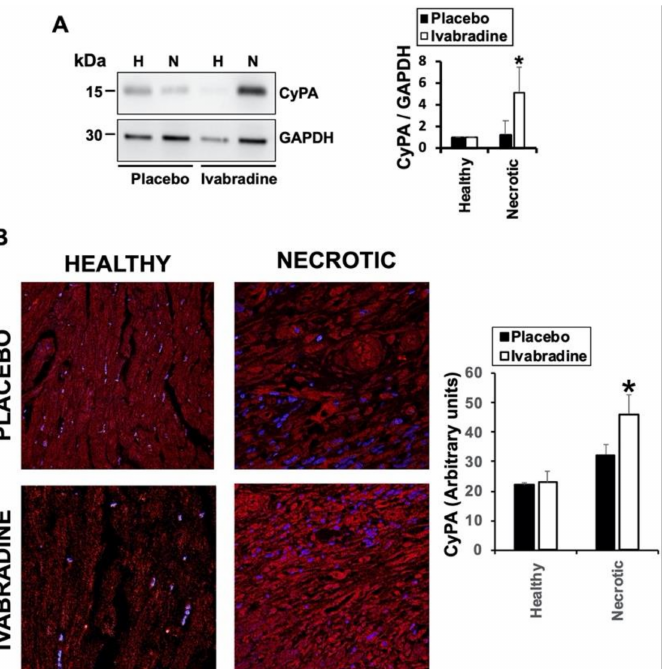
Figure 2. Ivabradine increases de-expression of cyclophilin-A in the hearts of pigs subjected to IR. ( A ) Immunoblot detection of cyclophilin-A (CypA) and Glyceraldehyde-3-phosphate dehydrogenase (GAPDH) as loading control in heart lysates from placebo and Ivabradine pigs subjected to IR. n = 9 Ivabradine/8 placebo. Mean ± SD; * p < 0.05 necrotic Ivabradine vs. placebo. ( B ) Confocal microscopy detection of cyclophilin-A (red) in heart sections of pigs treated with Ivabradine or placebo. n = 9 Ivabradine/8 placebo. Mean ± SD; * p < 0.05 necrotic Ivabradine vs.